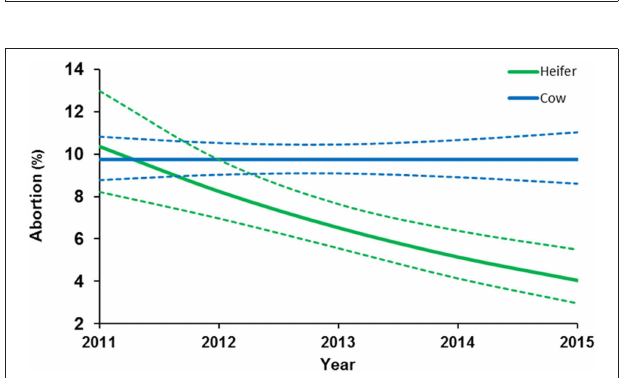
FIGURE 1 | N. caninum seroprevalence probability values estimated in dairy heifers over time after applying the control management in 2011. The estimated values and CI 95 % were obtained from GLM.